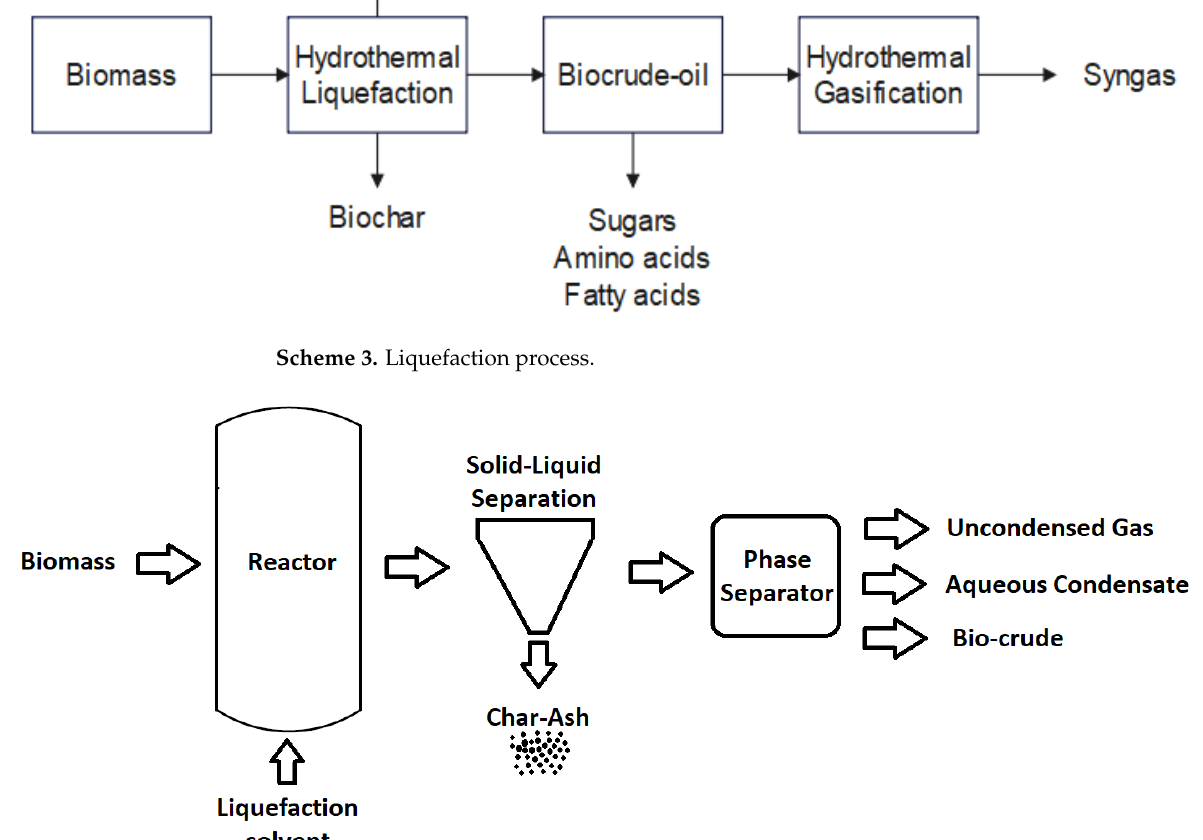
Table 4. Operating conditions and results obtained through biomass liquefaction.